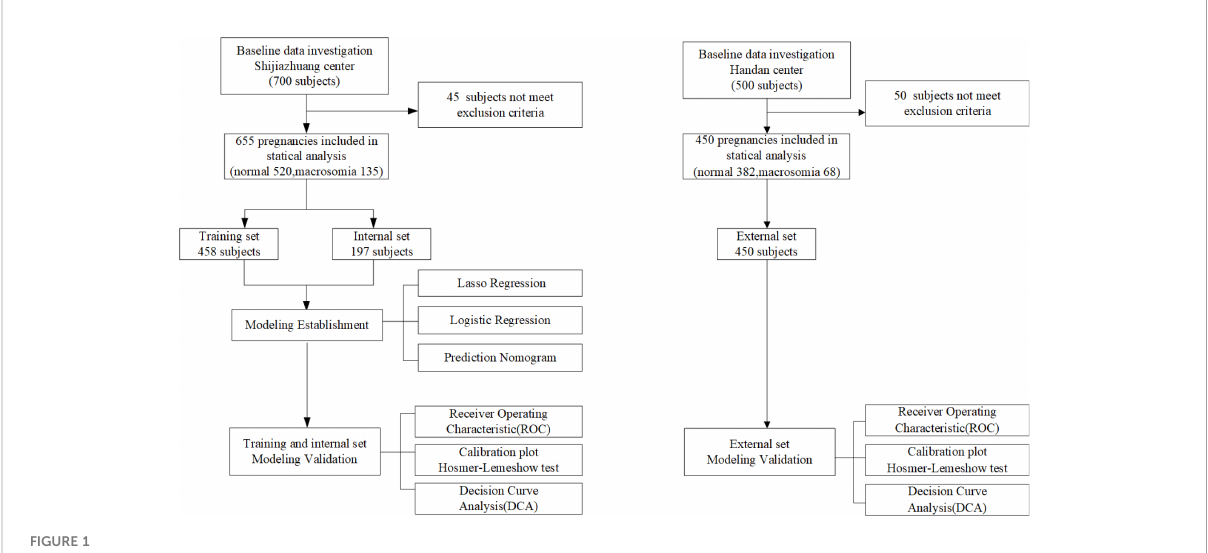
FIGURE 1 Study fl ow